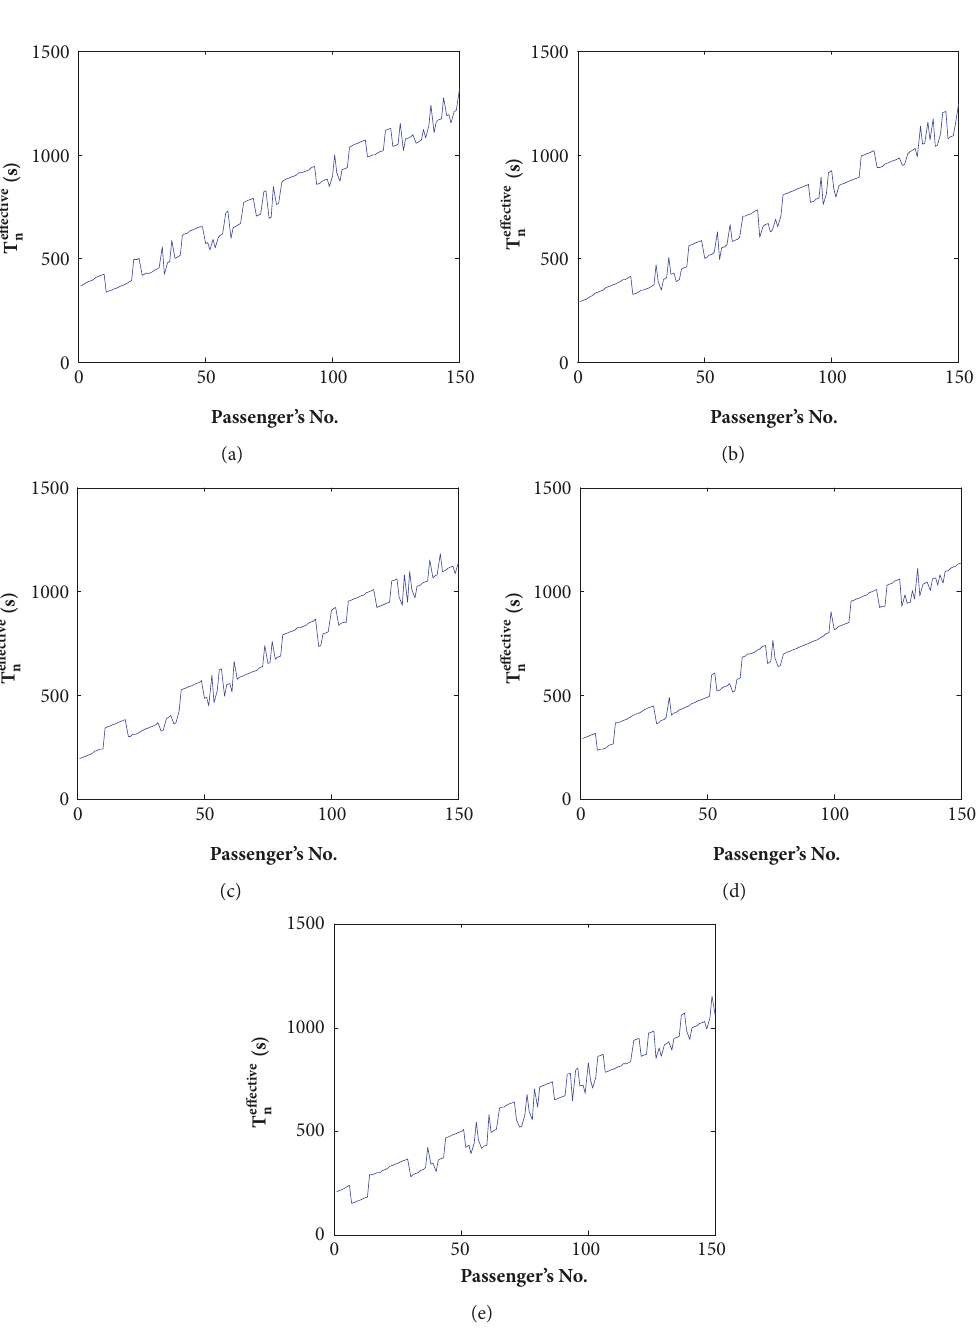
Figure 8: 𝑇 effective under different strategies during the boarding process, where (a)-(e) are, respectively, the random, BF, Wilma, Steffen, and n proposed